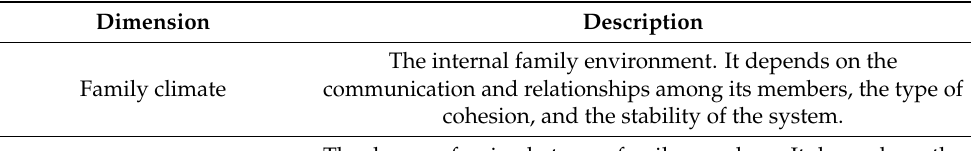
Table 1. Dimensions of family